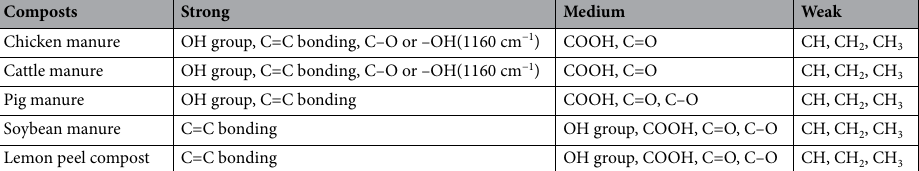
Table 7. Types of functional groups and their strength as determined by FTIR analysis on different composts.